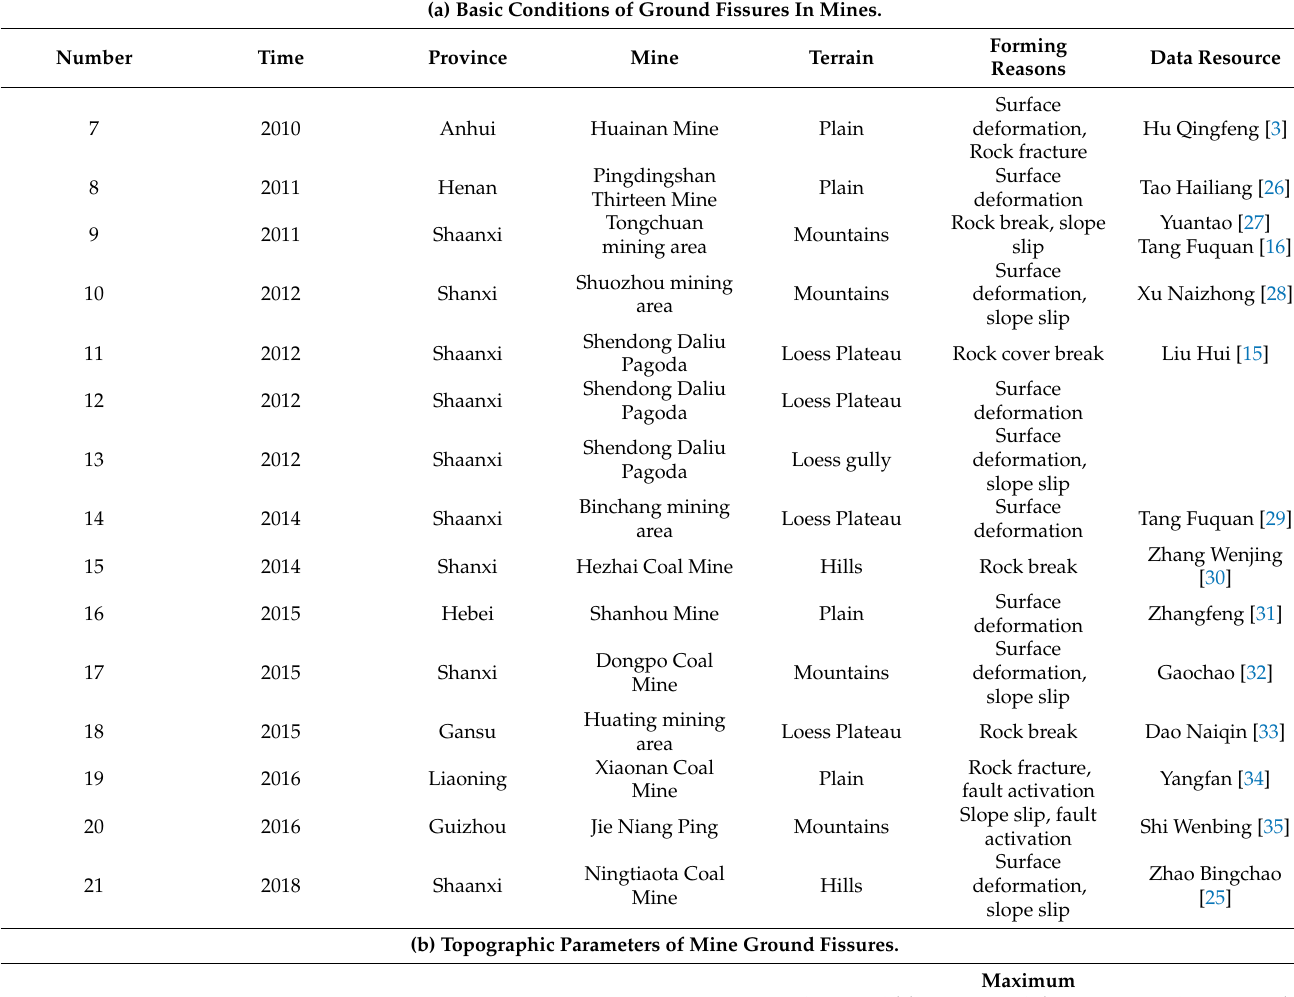
Table 1. Cont. (a) Basic Conditions of Ground Fissures In Mines.